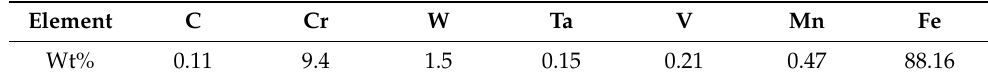
Table 1. Chemical composition of the CLF-1 steel powder.